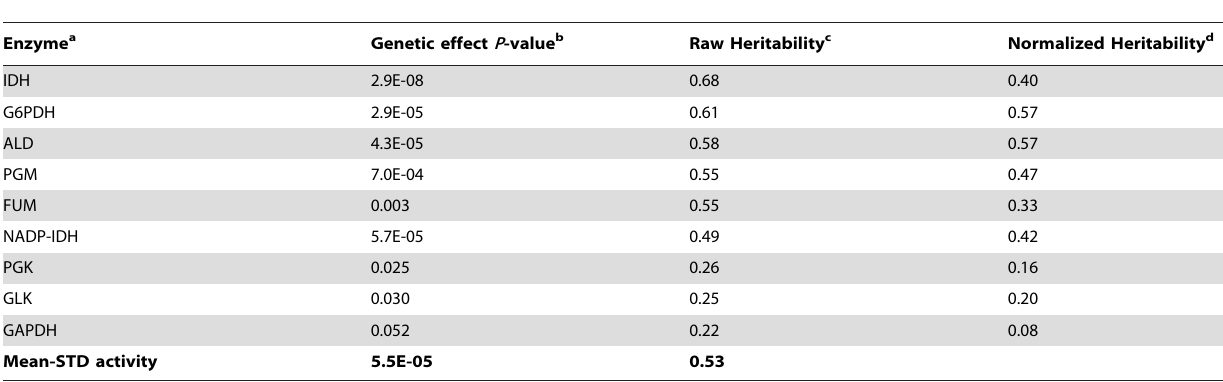
Table 1. Genetic effects and heritabilities of nine CCM enzyme activities.